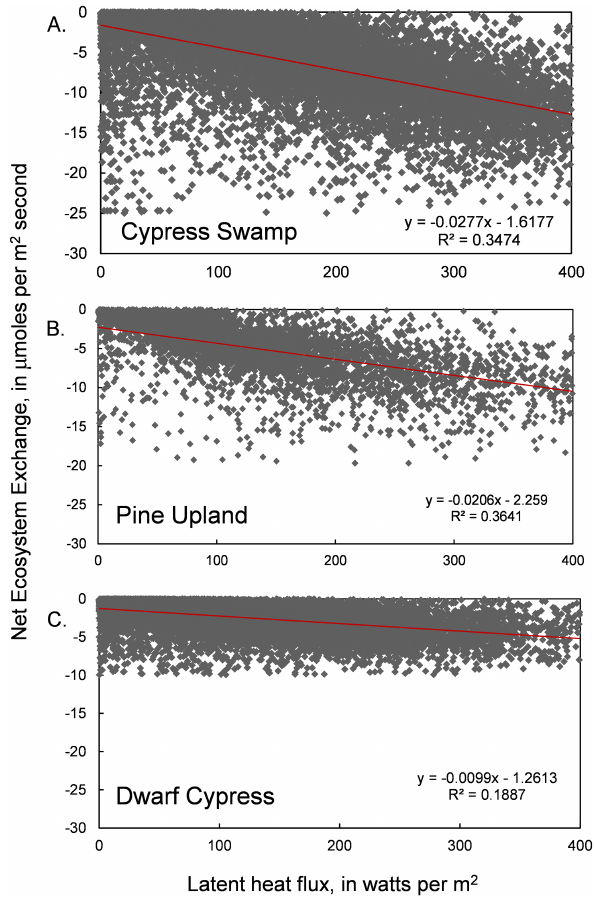
Figure 6. Relations between latent heat flux and net ecosystem ex-